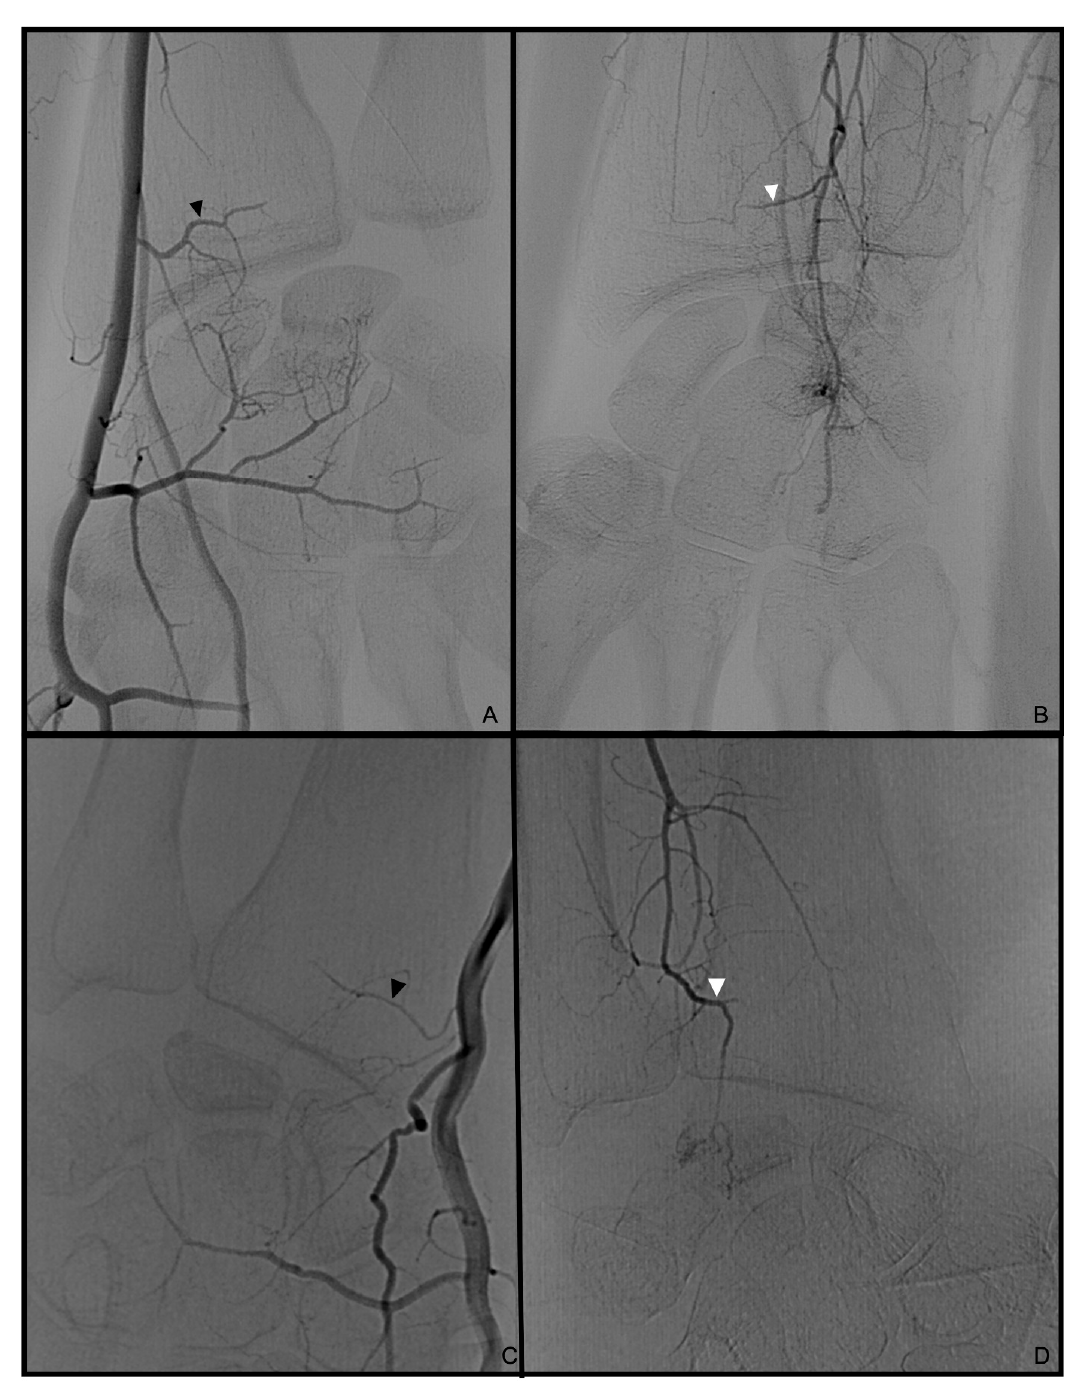
Figure 8. Palmo-dorsal superselective angiographies of the wrist. ( A , B ): Prominent palmar radio- carpal arch with strong PRCA and AIA. ( C , D ): The PRCA is below average in diameter, and the anastomosing branch of the AIA is not compensating for the lower flow of contrast agent. (cid:78) PRCA, (cid:52) anastomosing branch of the AIA (PRCA = palmar radiocarpal arch; AIA = anterior interosseous